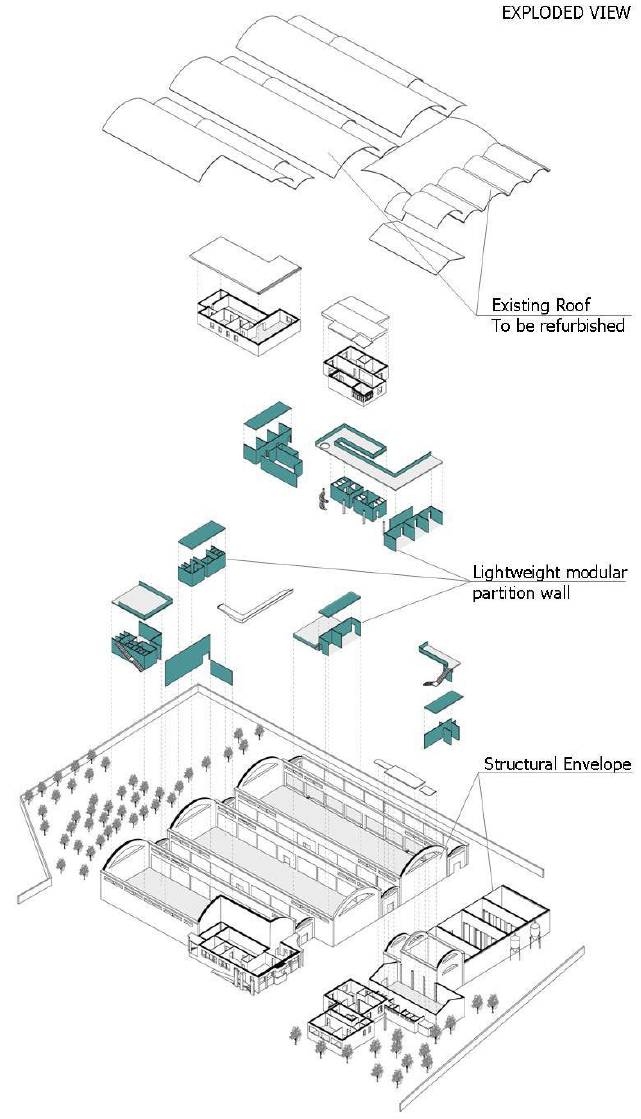
Figure 9. Axonometric view (in green modular partition walls to adapt the spaces).